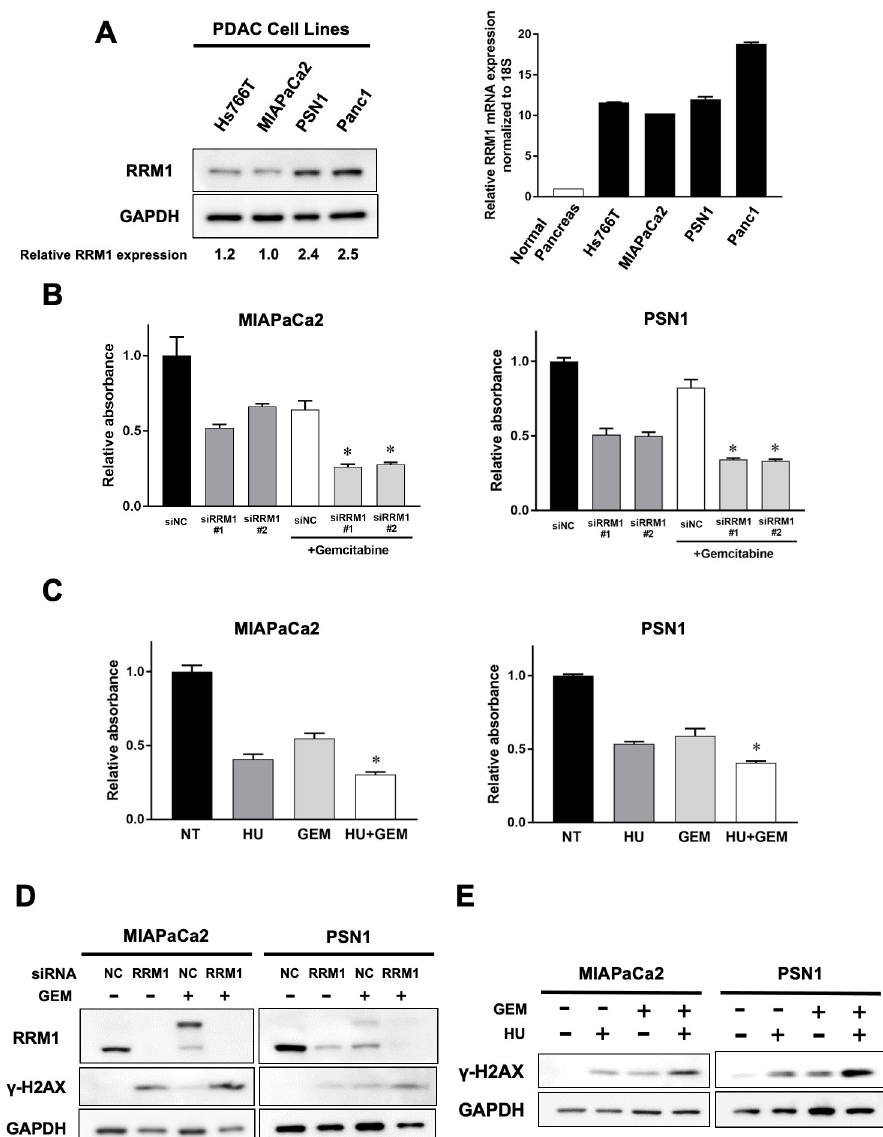
Fig 3. Augment of gemcitabine sensitivity of pancreatic cancer cells associated with RRM1 inhibition. (A) Left panel: Endogenous RRM1 protein expression in human pancreatic cancer cell lines by Western blotting. The numbers at the bottom indicate the relative intensity of the bands for RRM1 expression of Hs766T, PSN1, and Panc1 comparing to MIAPaCa2, which showed the lowest endogenous RRM1 expression in the panel (normalized by GAPDH). Right panel: Endogenous RRM1 mRNA expression relatively comparing to normal pancreas tissue. Of note, RRM1 expression was activated at various levels in four pancreatic cancer cell lines. ( B ) Cell viability assay after gemcitabine treatment for 72 hours together with siRRM1 or siNC treatment. Prior to gemcitabine treatment, cells were treated with siRRM1 or siNC for 24 hours. And then cells (MIAPaCa2 5 × 10 3 , PSN1 7.5 × 10 3 ) were seeded and incubated overnight. Attached cells were treated with or without gemcitabine treatment (15 nM for MIAPaCa2 and 5 nM for PSN1 cells) for 72 hours. Error bars represent mean ± SD. � p < 0.05 vs siNC-treated cells with gemcitabine. Each data point was evaluated as relative absorbance normalized to siNC control without treatment. Each experiment was performed in duplicate. (C) Cell viability assay after hydroxyurea, gemcitabine, and gemcitabine coadministrating with hydroxyurea for 72 hours. Drug concentration of hydroxyurea was determined based on the data of IC50 in each cell (S2A Fig). Hydroxyurea was treated at 750 μ M for MIAPaCa2 and 300 μ M for PSN1 cells. Gemcitabine was treated at 15 nM for MIAPaCa2 and 5 nM for PSN1 cells. Error bars represent mean ± SD. � p < 0.05 vs cells with gemcitabine- treated cells. Each data point was evaluated as relative absorbance normalized to no treatment control. Each experiment was performed in duplicate. (D), (E) Effects of RRM1 gene-silencing ( D ) and hydroxyurea ( E ) on gemcitabine-induced DNA damage. DNA damage was evaluated by γ -H2AX expression using Western blotting. (D)